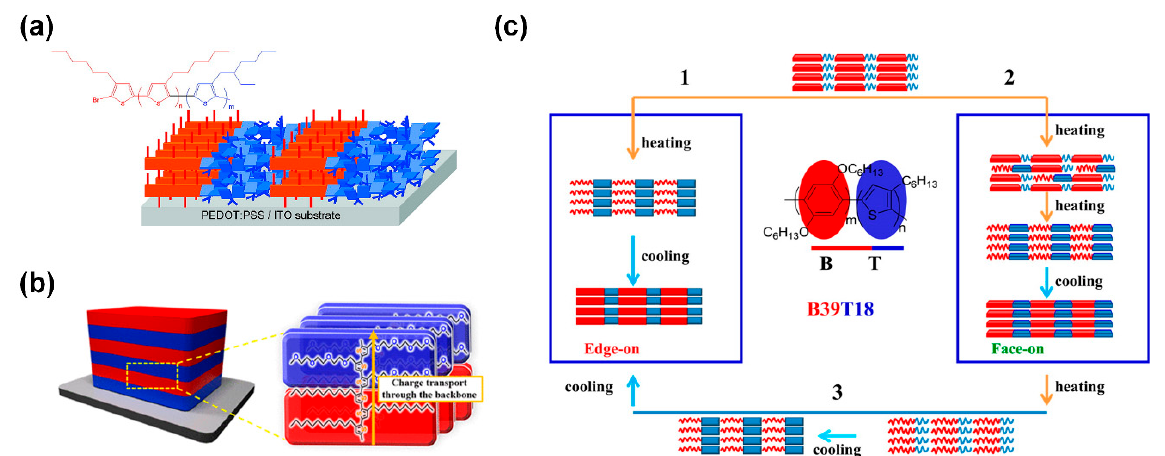
Figure 10. ( a ) “Edge-on” orientation of poly(3-hexylthiophene- b -3-(2-ethylhexyl)thiophene)s (P3HT- b -P3EHT) in thin film; (Reprinted with permission from Ref [62]. Copyright American Chemical Society); ( b ) “end-on” orientation of poly(3- dodecylthiophene)- b -poly(3-(2-(2-(2-methoxyethoxy)ethoxy)ethoxy)methyl thiophene) copolymer (P3DDT- b -P3TEGT) in thin film; (Reprinted with permission from Ref [65]. Copyright American Chemical Society); ( c ) three different self-epitaxial crystallization circles by controlling the heating process for poly( p -phenylene)- b -(3-hexylthiophene) (PPP- b -P3HT). (Reprinted with permission from Ref [111]. Copyright American Chemical Society).